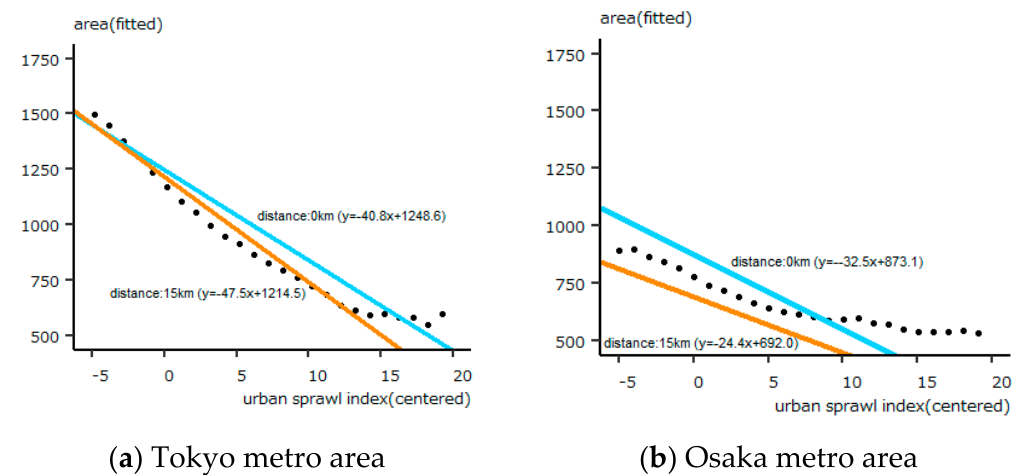
Figure 11. Average plot sizes by distance from DID. ( a , b ) demonstrate the results of Tokyo metro area and Osaka metro area, respectively. Black dots denote the average area of the farmland parcels by sprawl index. Except for distance and sprawl index, the average values of all of the variables were substituted in the estimated equation.